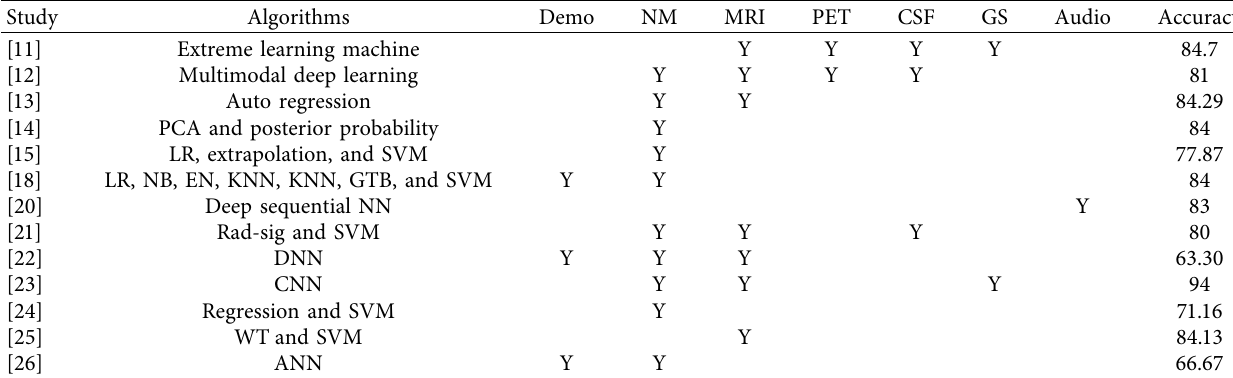
Table 1: Studies using longitudinal data for early AD diagnosis.